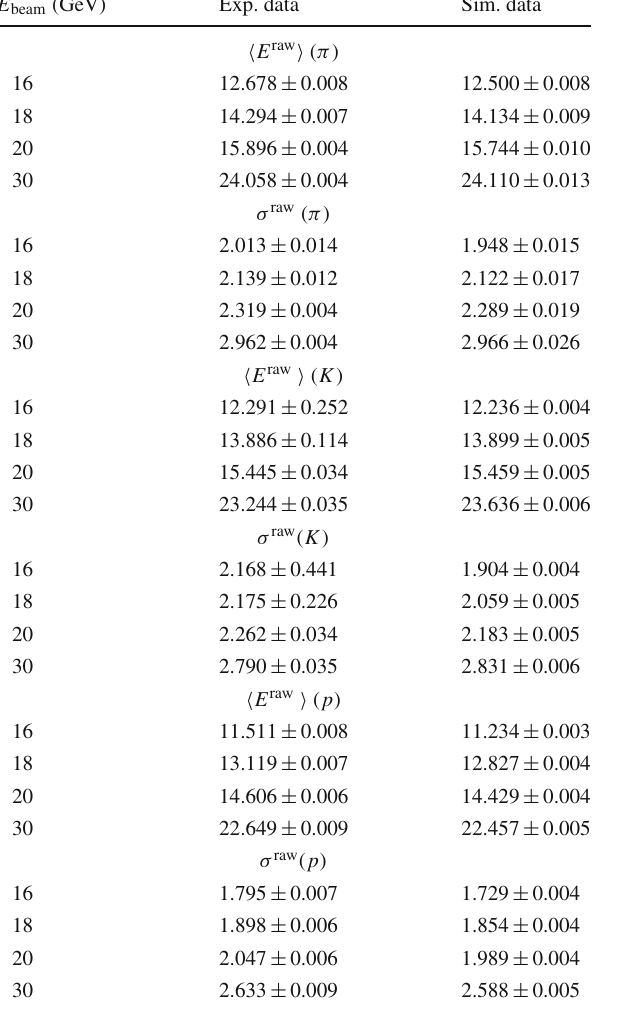
Table 5 Energy responses ( (cid:6) E raw (cid:7) ) and resolutions ( σ raw ) obtained fitting Gaussian functions to the experimental and simulated E raw dis- tributions of pions ( π ), kaons ( K ) and protons ( p ) with different beam energies. Uncertainties correspond to statistical uncertainties on the fit parameters